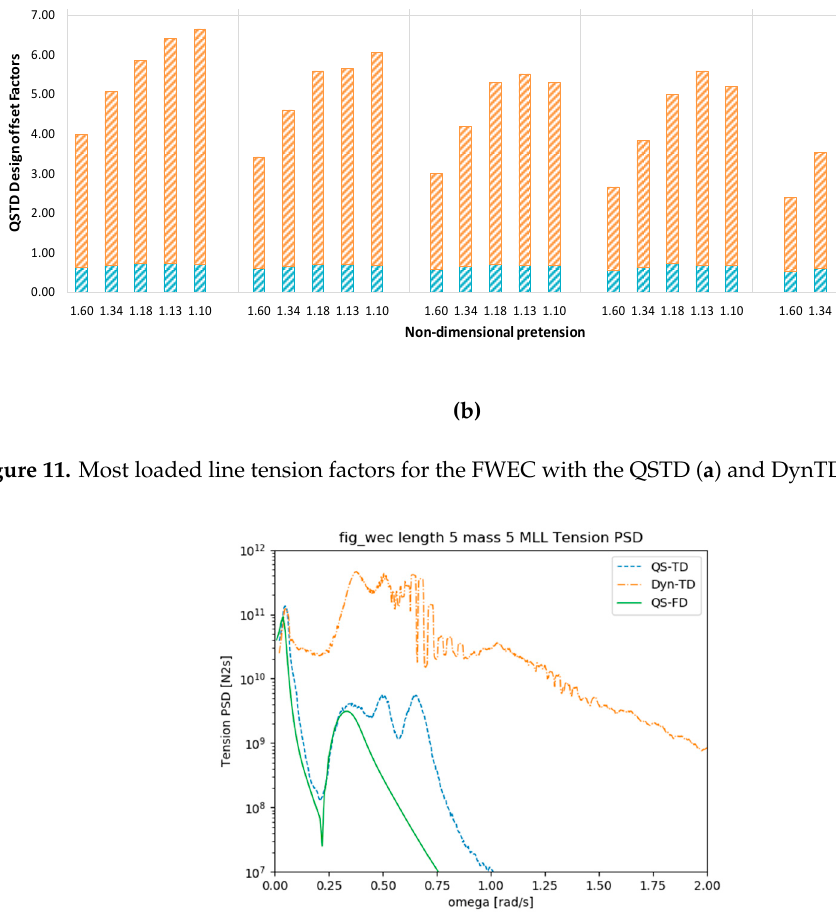
Figure 12. Most loaded line tension PSDs comparisons with the approaches presented.